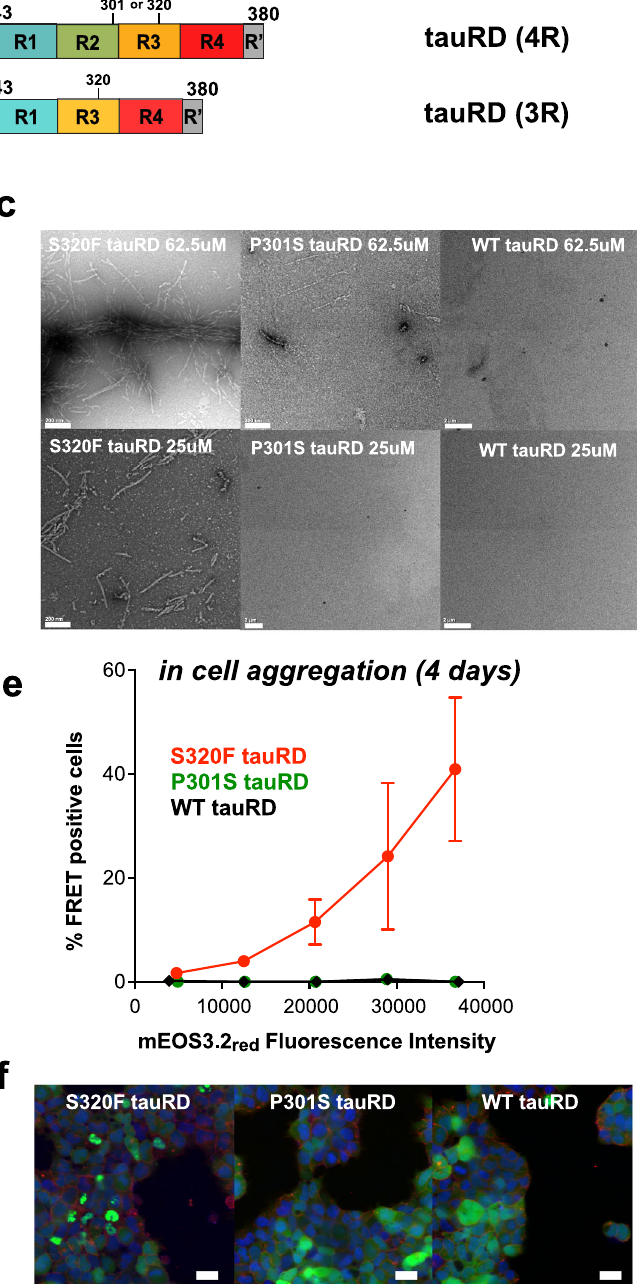
or mutant tauRD fused to mEOS3.2 in HEK293T cells. HEK293T cells expressing S320F, P301S, or WT tauRD-mEOS3.2 were fi xed on Day 4. After photoconversion with UV, a portion of mEos3.2 green was converted to mEOS3.2 red, and FRET could then be detected. e FRET (tauRD-CFP/tauRD-mCherry) was measured by fl ow cytometry on n =3 biological replicates of at least 10,000 cells per condition of S320F (red), P301S (green), or WT (black) after 4days. The comparison was con- ducted at multiple fl uorescent intensity levels of mEOS3.2 red . Data are shown as averages with 95% CI across three experiments. f Representative images of S320F, P301S,andWTtauRD-mEOS3.2expressedHEK293Tcellspriortophotoconversion. mEOS3.2 (green), Hoechst33342 (blue, nuclei stain), and Wheat Germ Agglutinin (red, cell membrane stains) fl uorescence signals are shown in green and blue, respectively. Scale bar, 15 μ m, shown in